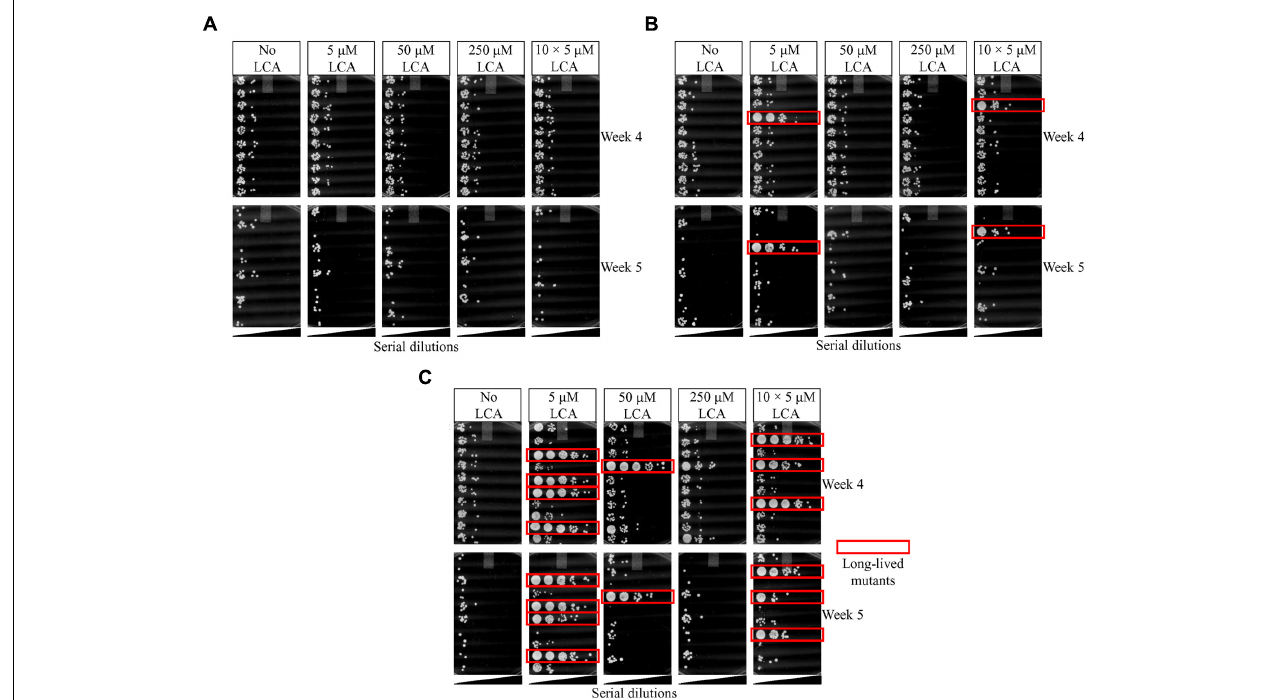
FIGURE 3 | Spot-assays of cell survival for each of the three consecutive steps of the LCA-driven selection of long-lived yeast species under laboratory conditions. The selection steps were carried out as outlined in Figures 1 and 2 . (A) No long-lived mutant yeast species were found at the end of the first selection step. (B) Four long-lived mutant yeast species were recovered at the end of the second selection step. (C) Sixteen long-lived mutant yeast species were recovered at the end of the third selection step.